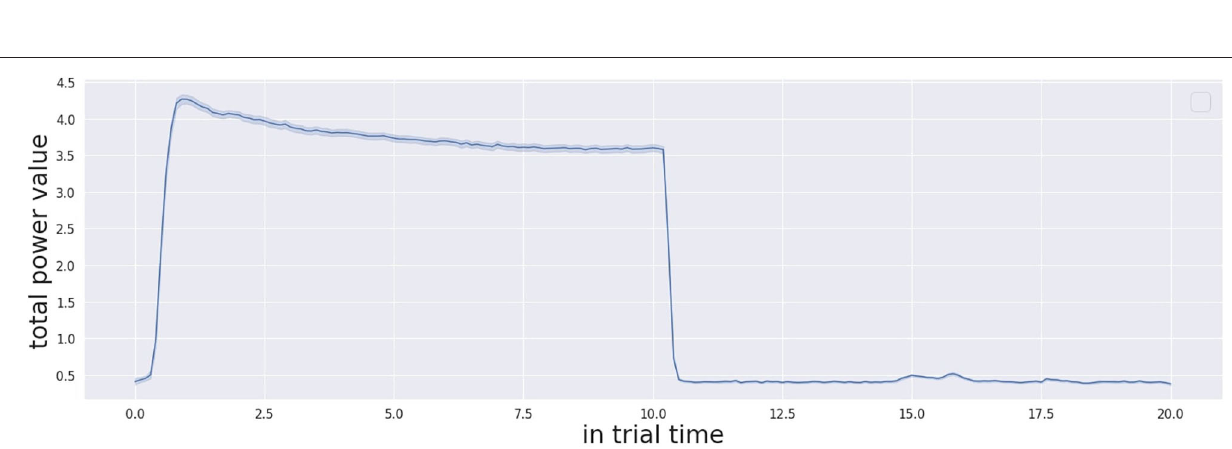
FIGURE 7 | Audio power profile across the whole trial time (20 s) during all the trials.